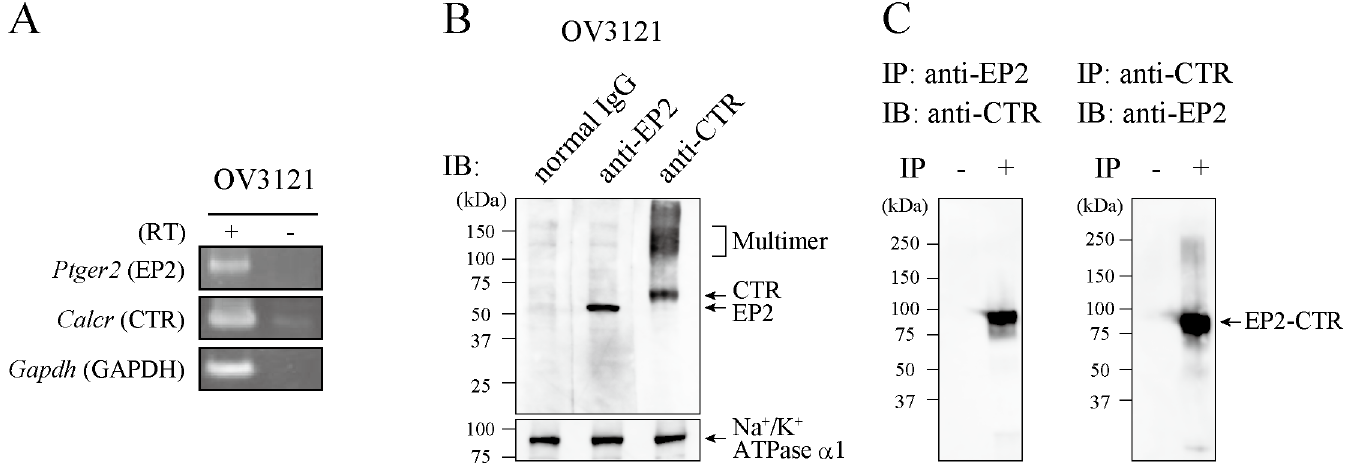
Fig 1. EP2 interacts with CTR in the mouse ovarian granulosa cell line, OV3121. (A) Ptger2 and Calcr mRNA expression in OV3121 cells. Total RNA was isolatedfrom OV3121 cells, and first strand cDNA was synthesized with (RT+) or without (RT-) reverse transcriptase, followedby RT-PCR. Gene symbols are indicatedin italic , and their protein names are presented in parentheses. The Gapdh gene was used as an internalcontrol. Abbreviations: Ptger2 (EP2), prostaglandinE2 receptor2; Calc r (CTR), calcitoninreceptor; Gapdh (Gapdh), glyceraldehyde-3-phosphate dehydrogenase. (B) EP2 and CTR expression in OV3121 cells. Western blotting using rabbit monoclonal anti-EP2 (ab167171)and anti-CTR (ab11042)antibodiesdetected specific bandsfor monomeric and/or oligomeric GPCR at the predictedsize. 1 μ g of normalrabbit IgG (sc-2027) was used as a negative control. A plasma membranemarker, Na + /K + ATPase α 1 was stainedwith the antibody (ab7671)as a loadingcontrol. (C) Detection of EP2-CTR interaction. Western blotting of EP2- (left) and CTR- (right) coimmunoprecipitatesusing respectiveanti-CTR (left) and anti-EP2 (right) antibody detected specific bandsfor EP2-CTR heterodimer. Corresponding amount of sample preparedwithout Co-IP (IP-) was used as negativecontrol.